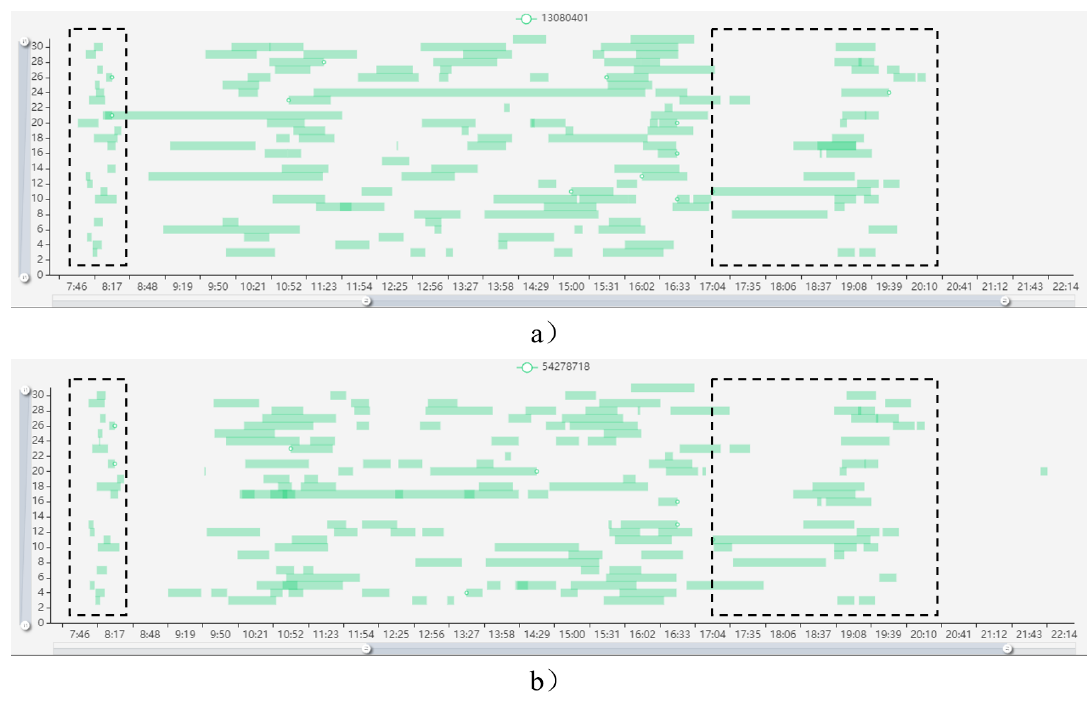
Figure 16. Passenger travel time pixel matrix view ( a ) Card number 13080401, ( b ) Card number 54278818.